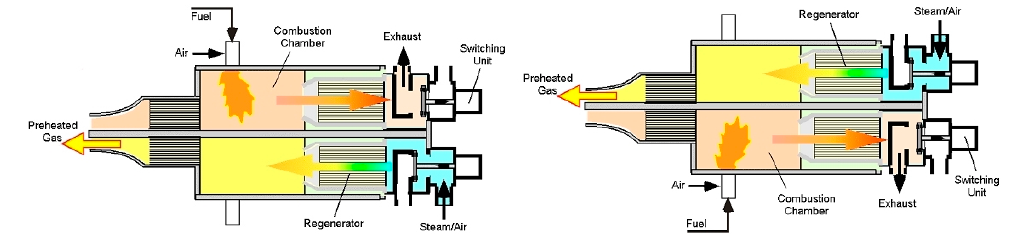
Figure 2. Concept of a high-temperature air/steam ceramic regenerator with a high-frequency alternating flow (with about 10–30 s for each mode) developed by Mochida and Hasegawa [5].